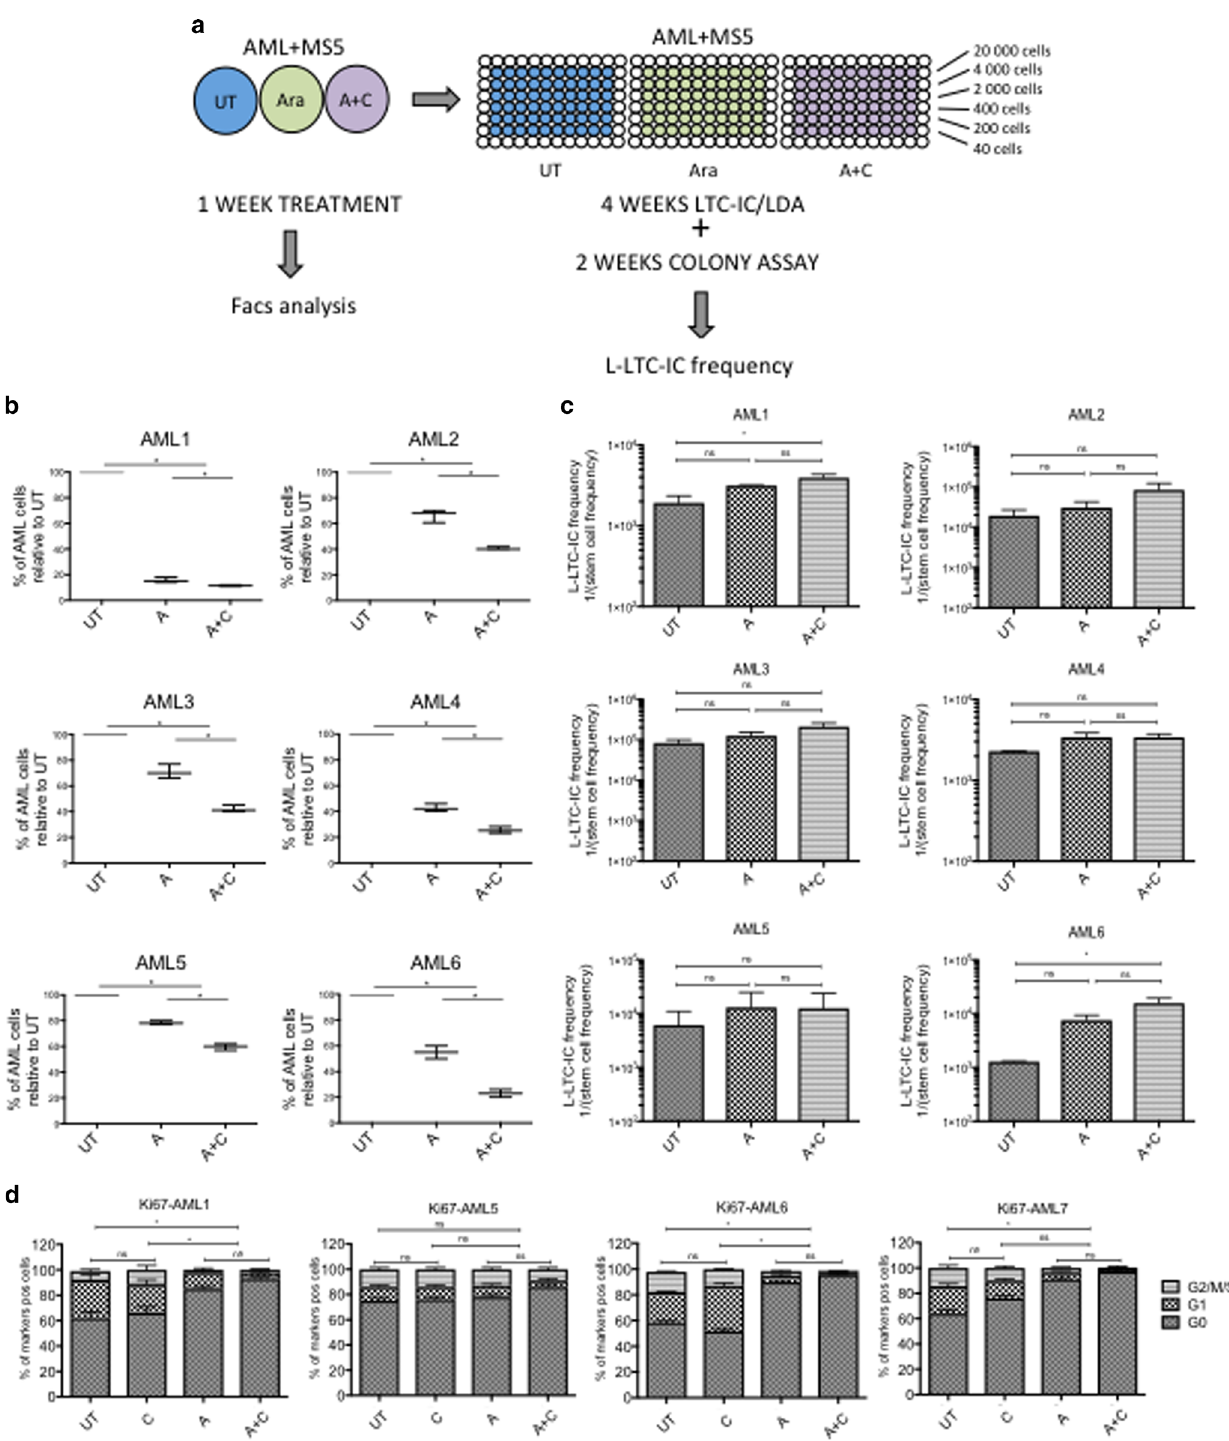
Fig. 2 CHK1i enhances AraC ef fi cacy to kill primary AML samples in vitro, but does not increase its effect on L-LTC-ICs depletion. a Scheme of AML short- term culture (STC) and long-term culture (LTC) analysis, using different treatment conditions. Three independent LTC-IC/LDA assays were performed in duplicate each time. b Percentage of AML survival after treatment, using counting beads, and normalizing to the untreated condition. (UT n = 3; A n = 3; A+C n = 3; NS = not signi fi cant). c L-LTC-IC frequency of AML subjected to 1 week of treatment, 4 weeks of LTC in a limiting dilution assay (LTC-LDA) and 2 weeks in methylcellulose. (UT n = 3; A n = 3; A+C n = 3; NS = not signi fi cant). d Cell cycle analysis of four AML samples 1 week after treatment, looking at Ki67/DAPI expression. (UT n = 3; C n = 3; A n = 3; A+C n = 3). Statistical test here related to cells in G0. * p <